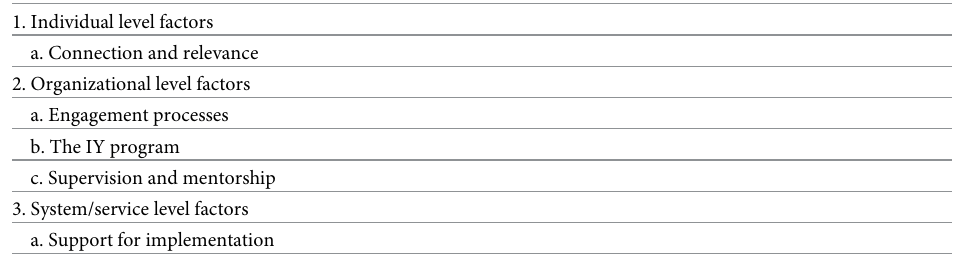
Table 1. Barriers and facilitators: Themes and